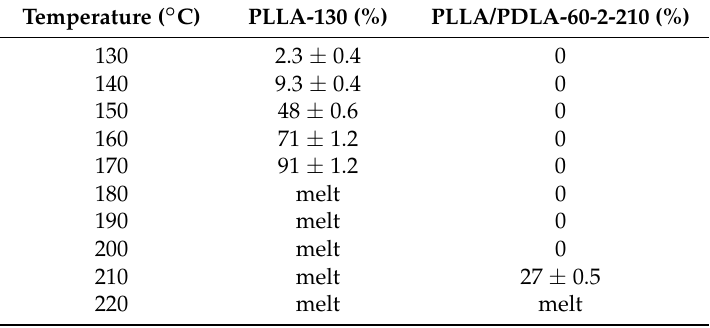
Table 5. Shrinking percentages of PLLA-130 and PLLA/PDLA-60-2-210 fibers at different temperatures.